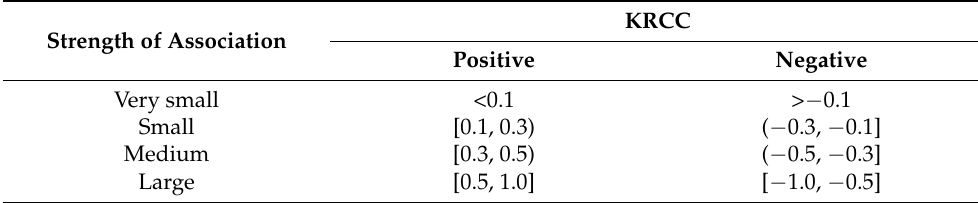
Table 2. Rule of Thumb of Interpreting the Size of KRCC.